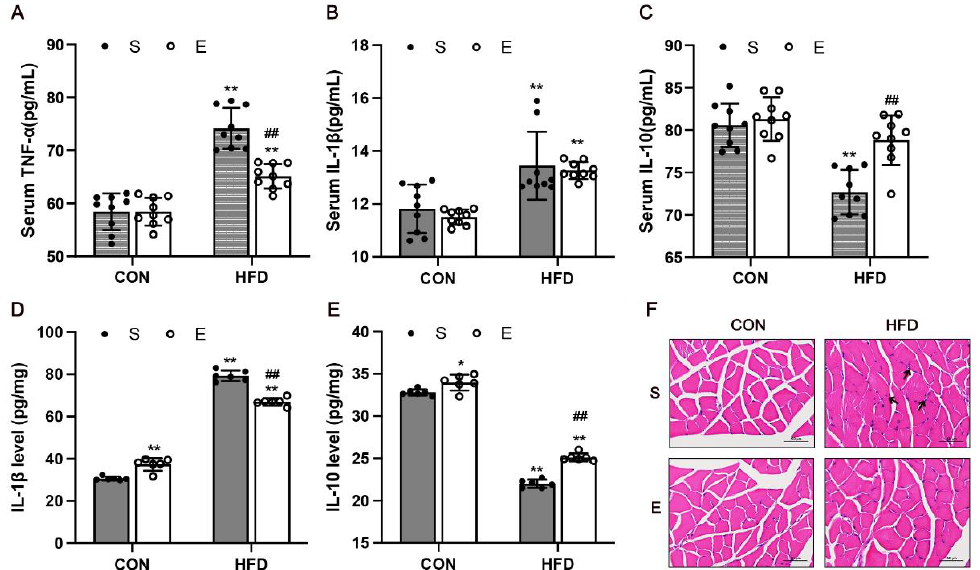
Figure 5. Aerobic exercise attenuated skeletal muscle inflammation. ( A ) TNF- α , ( B ) IL-1 β , and ( C ) IL-10 levels in serum by ELISA. ( D ) IL-1 β and ( E ) IL-10 levels in skeletal muscle by ELISA. ( F ) Hematoxylin and eosin (H&E) staining of skeletal muscle (scale bar = 50 µ m). Black arrows indicate inflammatory infiltration. CON, normal control; HFD, high-fat diet; S, sedentary; E, exercise. NS, normal sedentary; NE, normal + exercise; HS, HFD sedentary; HE, HFD + exercise. * p < 0.05, ** p < 0.01 vs. NS group; ## p < 0.01 HS group. n = 6–9.